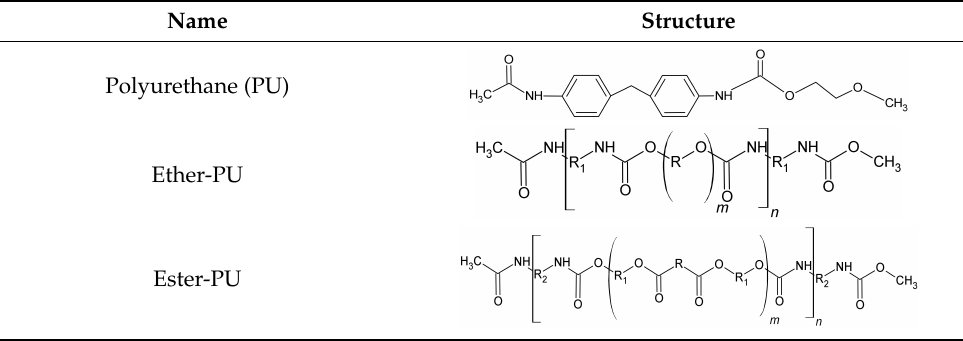
Table 4. Backbone structural formula of polyurethane (PU), ether-PU and